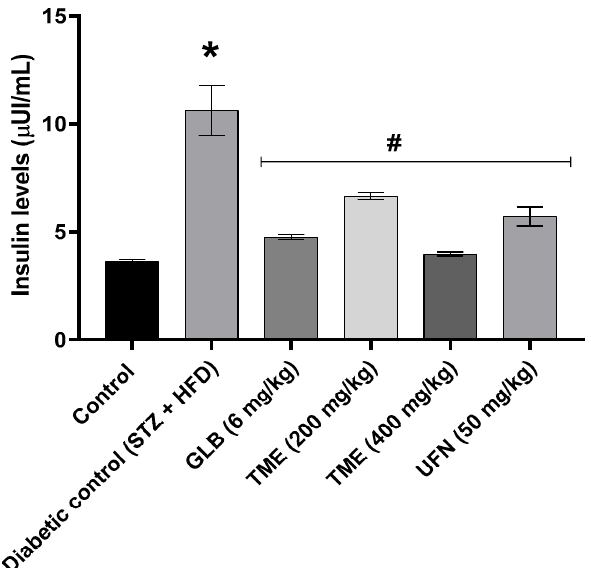
Figure 4. Effect of TME (200 and 400 mg/kg) of B. eriophora and isolated UFN on fasting insulin levels. Values are represented as mean ± SD, n = 3. * represents a significant difference between the control group and the diabetic control group (STZ + HFD). Whereas # represents a significant difference between the diabetic control group with all the treatment groups of TME and UFN. HDL; high-density lipoprotein, STZ; streptozotocin, STD GLB; standard glibenclamide, TME; total methanol extract, UFN; Umbelliferone.